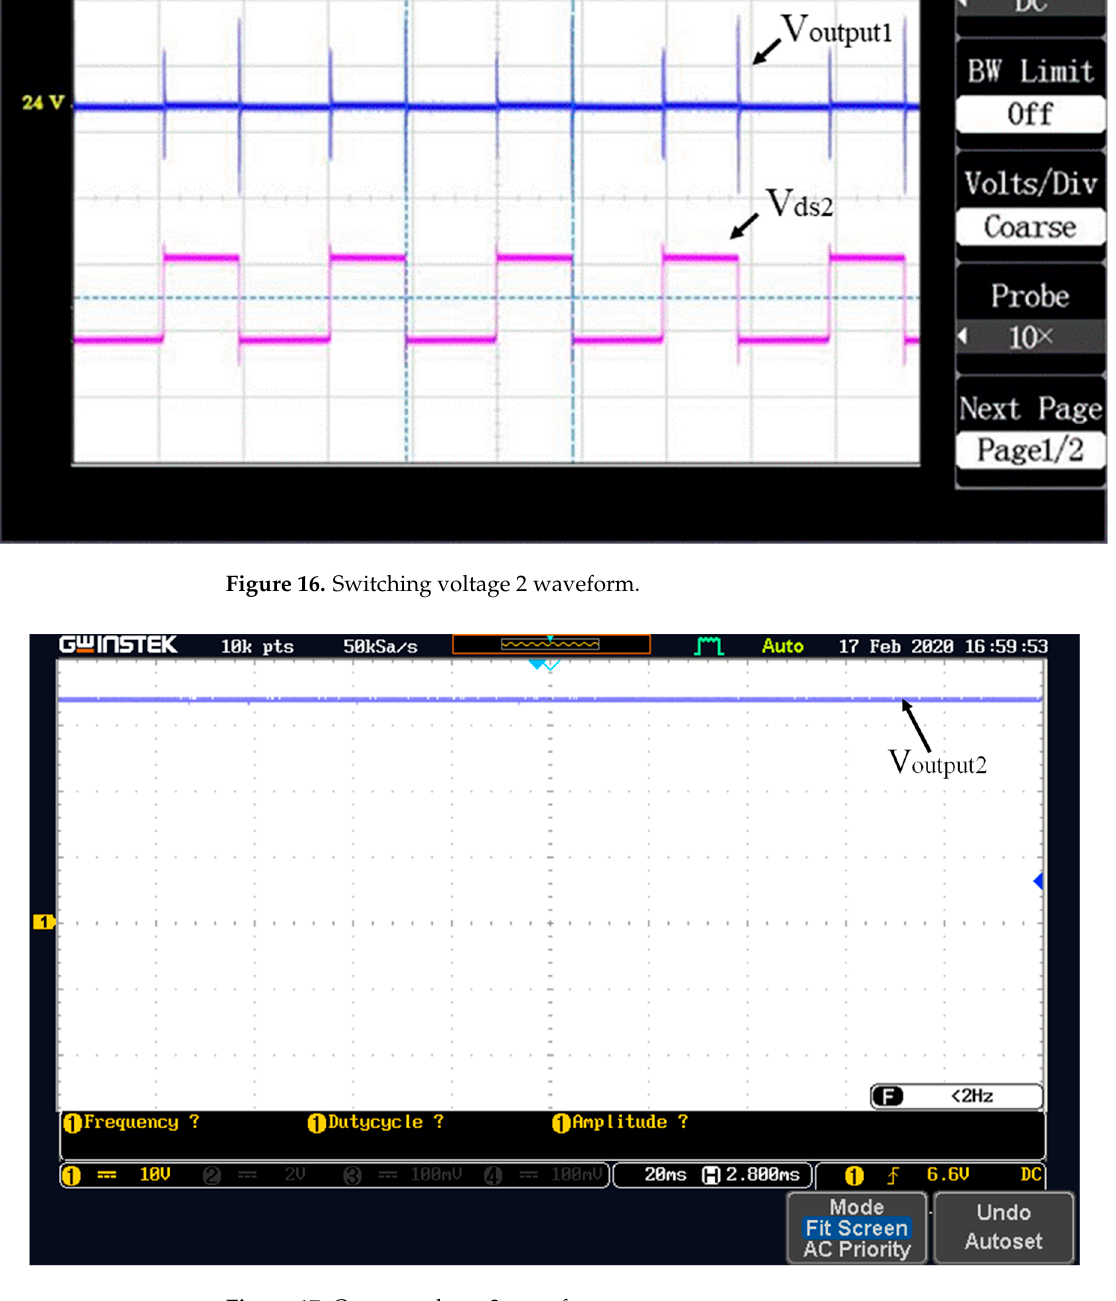
Figure 17. Output voltage 2 waveform.